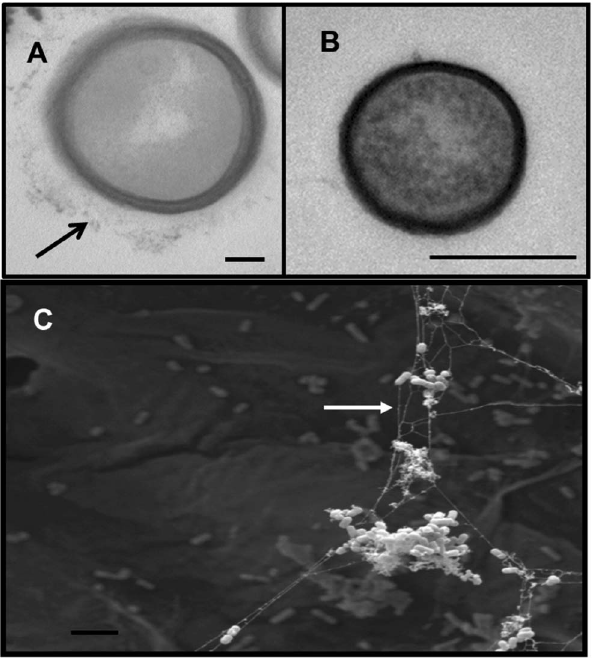
Fig. 2. Transmission and scanning electron microscopy analysis of L. monocytogenes EPS production. L. monocytogenes 10403S bacteria in biofilms formed on dialysis tubing membranes (regenerated cellulose) (A) (bar 5 100 nm) or planktonic bacteria grown in broth culture (B) (bar 5 500 nm) were examined by TEM at 72 hours post-inoculation. (C) SEM of a L. monocytogenes biofilm developed on regenerated cellulose at 24 hours post-inoculation (bar 5 10 m m). Arrows indicate EPS. For TEM, samples were fixed with 25% glutaraldehyde, rinsed with cacodylate buffer and stained with ruthenium red to visualize EPS material. For SEM, samples were rinsed with multiple dilutions of ethanol prior to visualization.